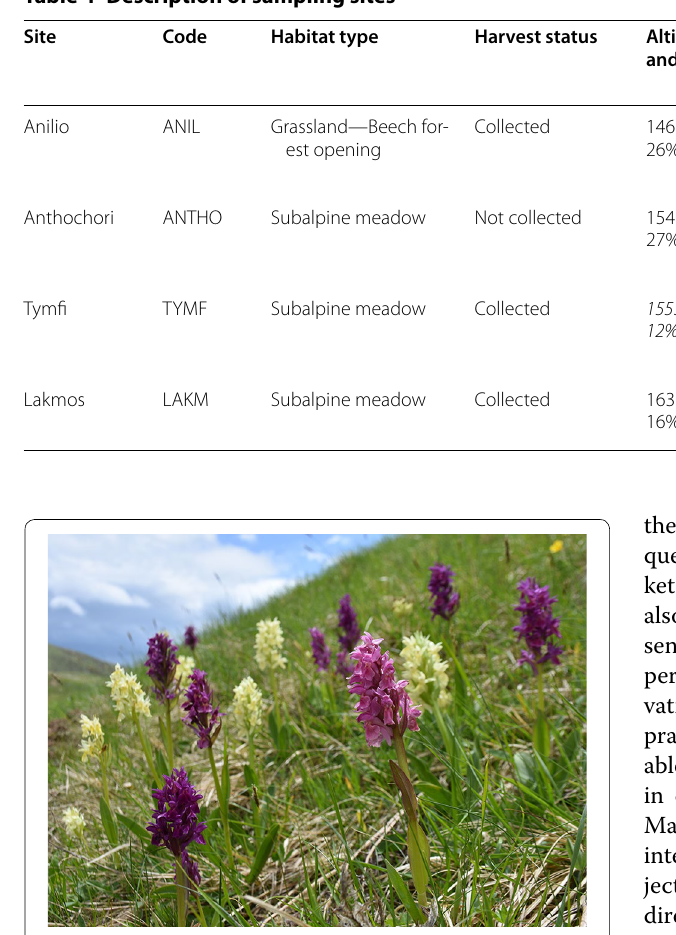
Fig. 2 The Elder-flowered orchid, Dactylorhiza sambucina (L.) Soó (1962), showing its characteristic color variation (photo credits: Kalliopi